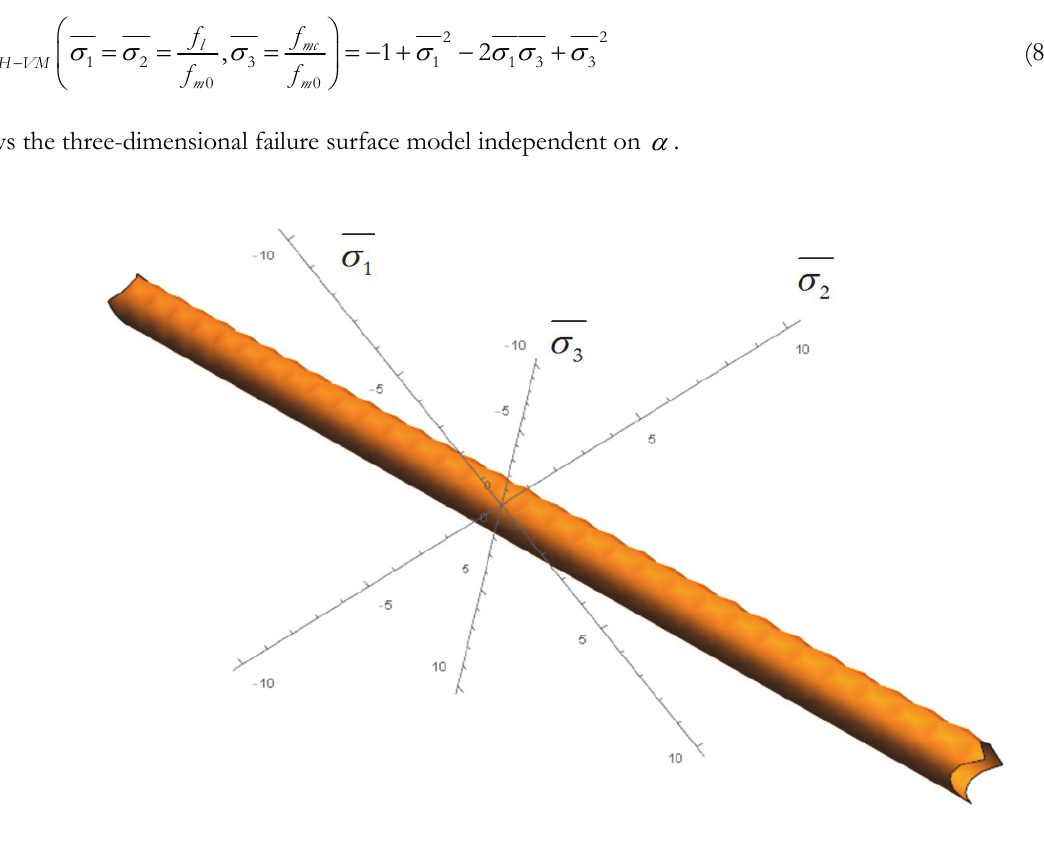
Figure 3: Failure surface according to a Henky-Von Mises model independent on 